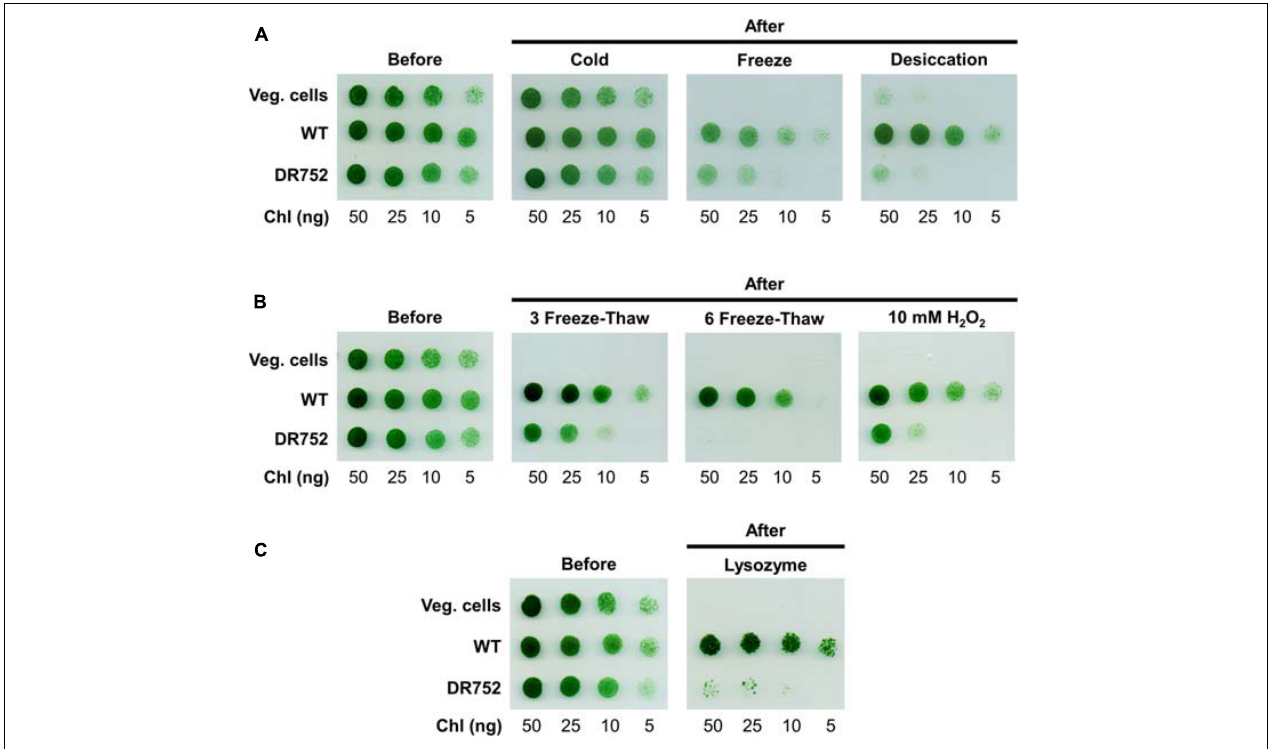
FIGURE 5 | Viability of WT vegetative filaments and the akinetes of WT and mutant DR752 exposed to different stress conditions. Vegetative cells (Veg. cells) and 3–4 months akinete-induced culture of WT and mutant DR752 were exposed to/treated with (A) cold, freeze and desiccation for 20 days, (B) three and six freeze-thaw cycles or 10 mM H 2 O 2 for 2 h and (C) 300 µ g ml − 1 lysozyme for overnight. Serial dilution and plating were performed on agar plates before and after treatments and incubated for 7 days to allow germination and pseudo colony